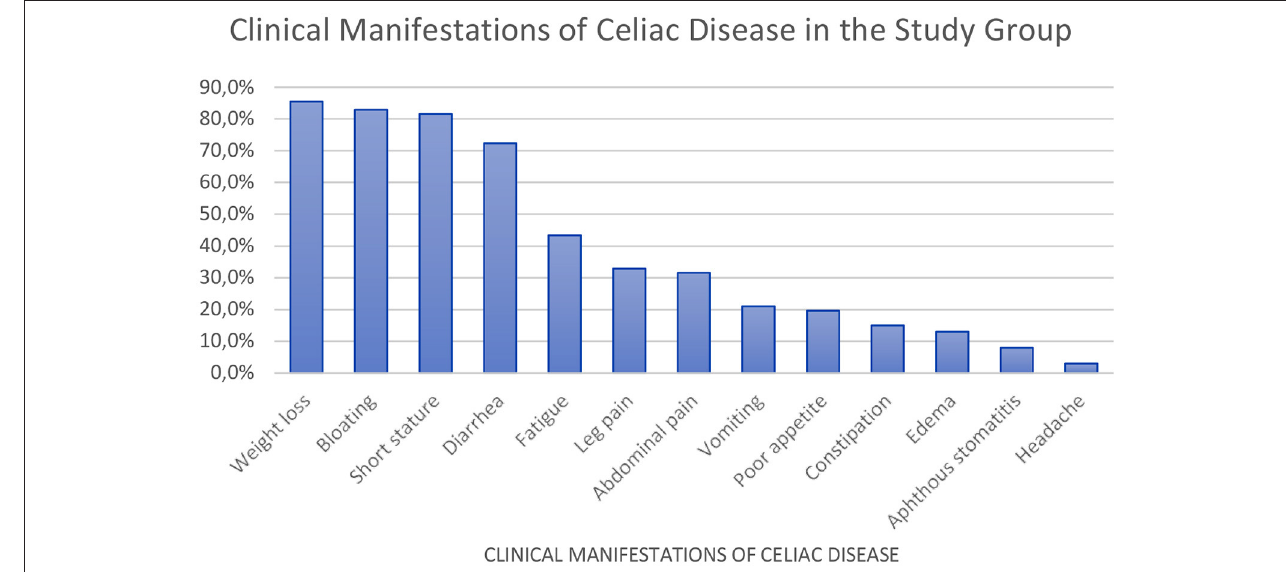
FIGURE 1 | Clinical manifestations of celiac disease in patients,